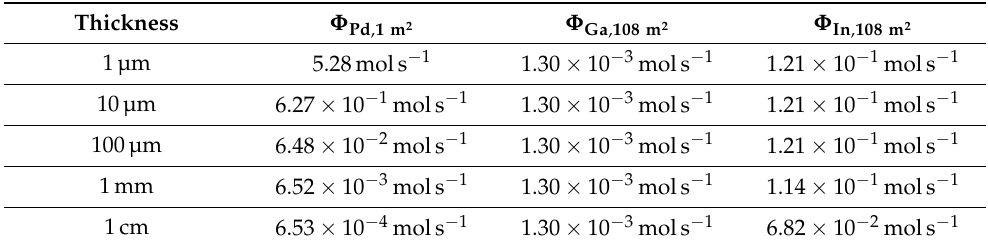
Table 4. Calculated flow rates through palladium, gallium and indium membranes of the same metal cost as a function of membrane thickness. All values calculated at 773K, 1atm retentate pressure and 0atm permeate